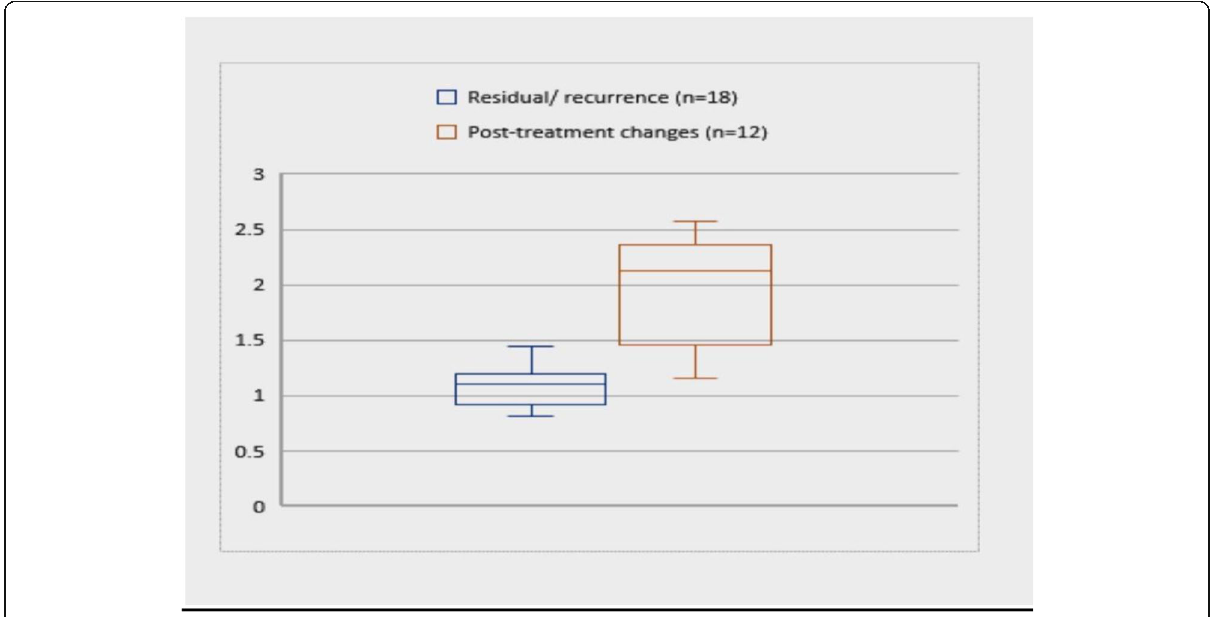
Fig. 7 Box and whisker plot. The plot shows the apparent diffusion coefficient (ADC) values of the suspicious lesions in the two study groups, with most of the lesions in the “ locoregional recurrence/residual tumour ” group exhibiting significantly lower ADC values than those in the “ post- treatment benign changes ”